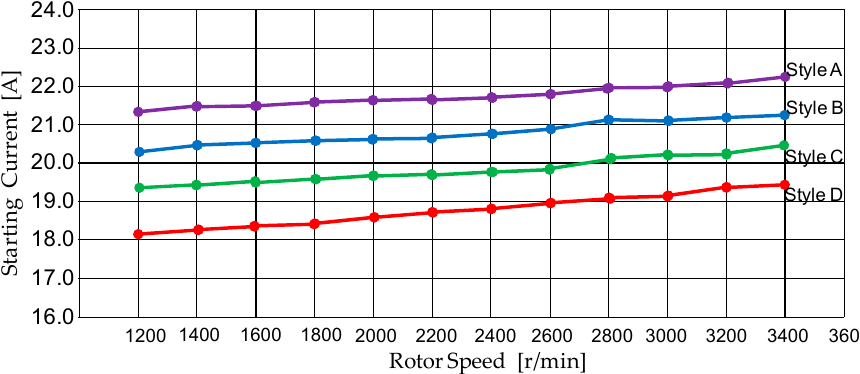
Figure 8. Poly-line graph of starting current for four kinds of SCSCRIMs under several speeds.